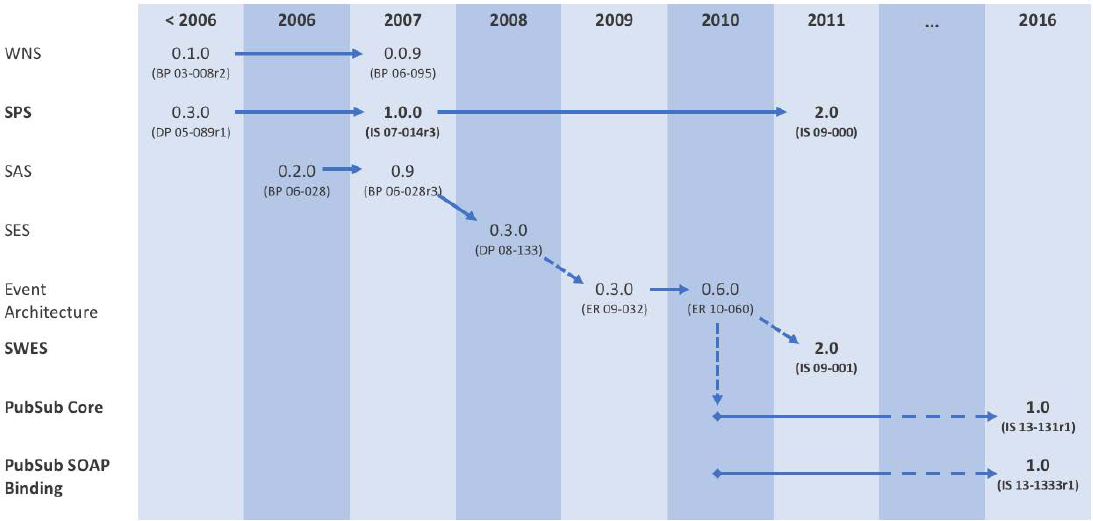
Figure 1. Overview and timeline of relevant OGC eventing-related work in the last decade. The rows show the roadmap of various documents; milestones are indicated with their version and their OGC reference number and type (Best Practice, Discussion Paper, Implementation Standard, and Engineering Report); and bold fonts highlight official OGC standards. See the end of the manuscript for a complete list of